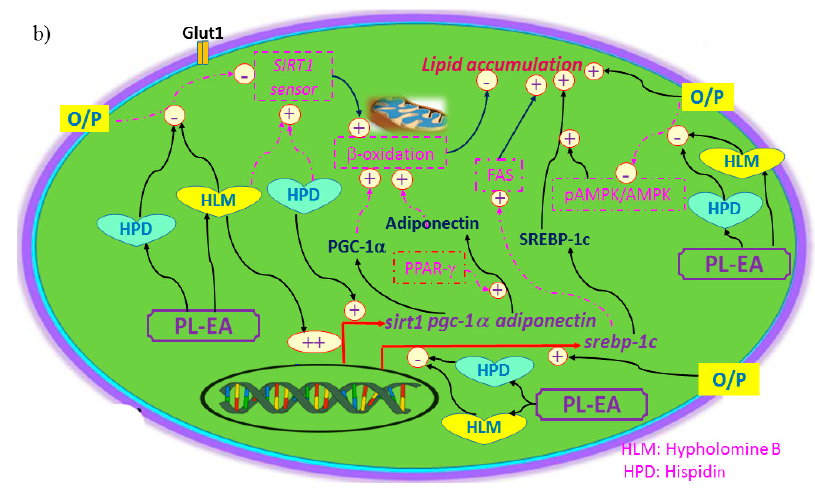
Figure 12. Mechanism of action related to the alleviative effect of NAFLD in mice with the ethyl acetate partition from Phellinus linteus ( a ) and that of in vitro hypolipidemic effect of hispidin and hypolomine B in HepG2 cell model ( b ). In Figure 12b, the items highlighted in pink are not shown in the HepG2 cell model but were found in the in vivo mice model. The purified active components from PL-EA used in the in vitro experiment are hispidin (HPD) and hypholomine B and isomers (HLM). ALT: alanine aminotransferase (GPT). AMPK: AMP-activated protein kinase . AST: aspartic